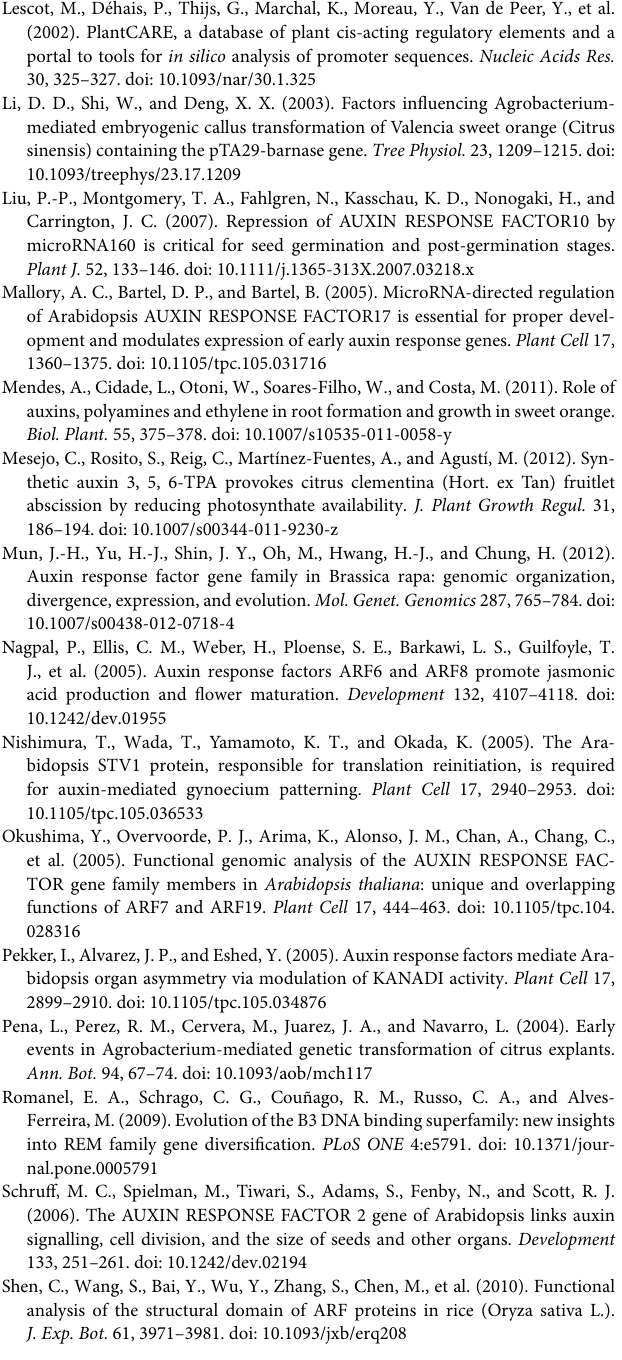
Figure S2 | Clade-wise distribution of conserved motifs in 18 CiARF proteins. Fifteen putative conserved motifs were identified in the CiARF protein using MEME search tool (http://meme.nbcr.net/meme/). Different motifs are indicated by different colors. The length of motif in each protein represents the actual length, and motif sizes are indicated at the bottom of the figure. Figure S3 | Clade-wise distribution of cis -motifs in 18 CiARF promoters. Fifteen putative cis -motifs were identified in the upstream promoter region of CiARF genes using MEME search tool (http://meme.nbcr.net/meme/). Different